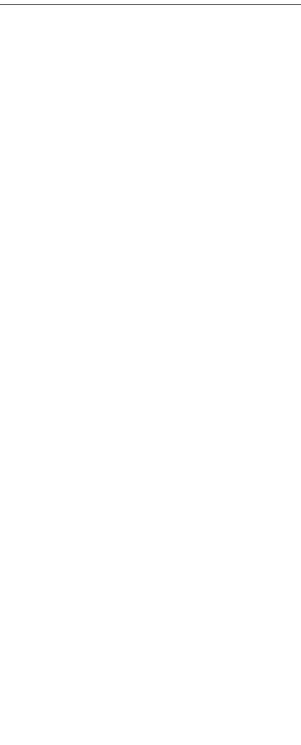
FIGURE 2 | Risk of bias assessments. Risk of bias legend. R, Bias arising from the randomization process; D, Bias due to deviations from intended interventions; Mi, Bias due to missing outcome data; Me, Bias in measurement of the outcome; S, Bias in selection of the reported results; O, Overall risk of bias. Domain 1: Risk of bias arising from the randomization process: The study conducted by Work et al. (34) was at high risk of bias because PCI vs no PCI was not strictly randomized. The study conducted by Cao et al. had “ some concerns ” because of no information about the random allocation sequence. RTOG 0937 had “ some concerns ” because baseline age was unbalanced between arms (P = 0.03). The other 16 studies were assessed as at low risk of bias. Domain 2: Risk of bias due to deviations from the intended interventions (effect of assignment to intervention): The CONVERT trial was assessed to have “ some concerns ” because it is unclear whether there were deviations from the intended intervention that arose because of the trial context. The UKCCCR/EORTC trial was assessed to have “ some concerns ” since there were deviations from the intended intervention that arose because of the trial context. The others were at low risk. Domain 3: Missing outcome data: This domain is dif fi cult to tell because most trials did not have a regular brain CT/MRI scan plan during the follow-up. In the trials that did have a pre-planned brain CT/MRI scan schedule, only one trial (IPC85) mentioned the compliance at some time point. Readers do not know how many data were missing. The UKCCCR/EORTC trial and HeCOG were at high risk because of no information about missing data. IPC85, the pooled analysis of IPC85+ IPC88, and the study conducted by Work et al. (35) were at high risk because many data were missing but there were no evidence that the result was not biased by missing data. The other 14 studies were at low risk. Domain 4: Risk of bias in measurement of the outcome: 14 studies were judged to be at high risk because the method of measuring the outcome (BM) was inappropriate. They performed brain MRI/CT when patients experience neurological symptoms. The other fi ve trials were at low risk because they had pre-planned brain MRI/CT scan during follow-up. Domain 5: Risk of bias in selection of the reported result: JCOG 9104, E7593, and the trial conducted by Gregor et al. (EORTC) had “ some concerns ” because of no information about pre- speci fi ed analysis plan or selection from multiple eligible analyses. Overall risk of bias: Only the studies conducted by Le Pechoux et al. and Takahashi et al. were judged to be at low risk of bias. The other 17 trials were judged as high risk of bias. This is mainly because of domains 3 and 4. CCRT, concurrent chemoradiotherapy; CEV, cyclophosphamide – epirubicin – vincristine; chemo, chemotherapy; CRT, chemoradiotherapy; ED, extensive-stage disease; EP, etoposide-platinum; LD, limited-stage disease; ODRT, once-daily radiotherapy; PCI, prophylactic cranial irradiation; SCLC, small cell lung cancer; SCRT, sequential chemoradiotherapy; TDRT, twice-daily radiotherapy; TRT, thoracic